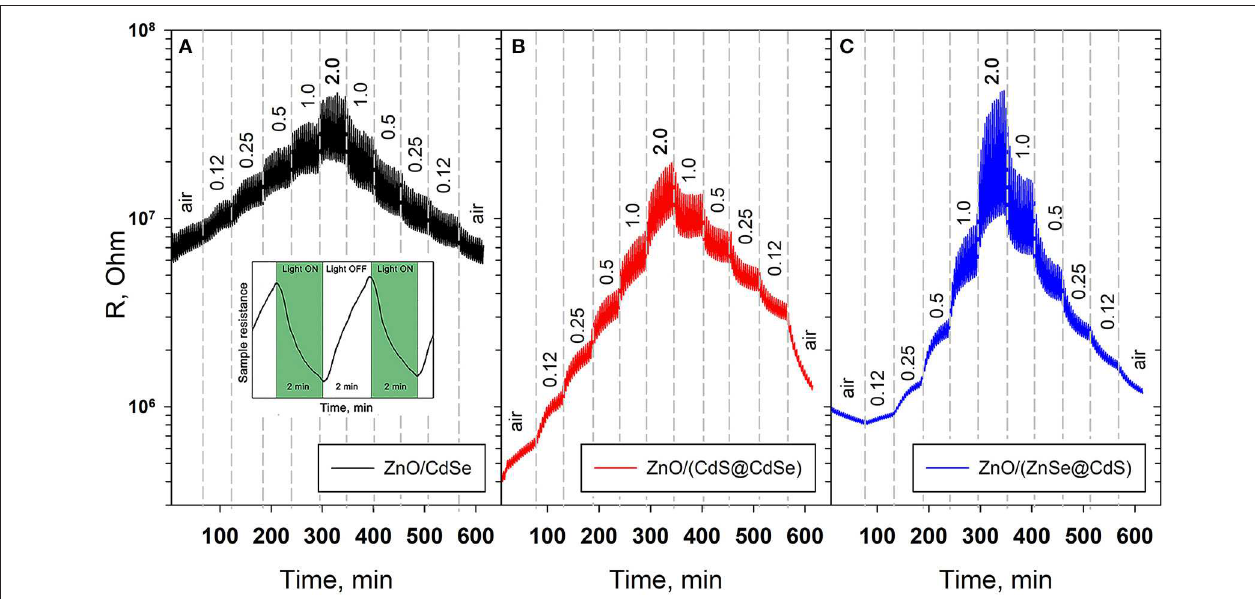
FIGURE 7 | Room temperature electrical resistance of (A) ZnO/CdSe, (B) ZnO/(CdS@CdSe), and (C) ZnO/(ZnSe@CdS) nanocomposites under periodic green light illumination ( λ max = 535nm) depending on NO 2 content in the gas phase (in ppm). Inset: change of the sensing layer resistance under periodic LED